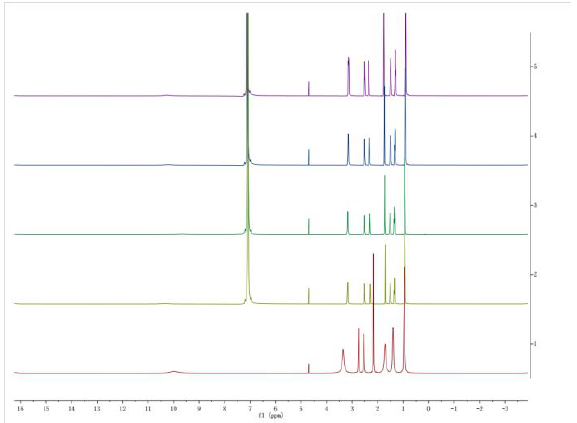
Figure 21. 1 H NMR of different molar ratios DES(1:2) and benzene (the DES mole concentrations are 1, 0.05, 0.1, 0.15, and 0.2 from the bottom up, respectively).